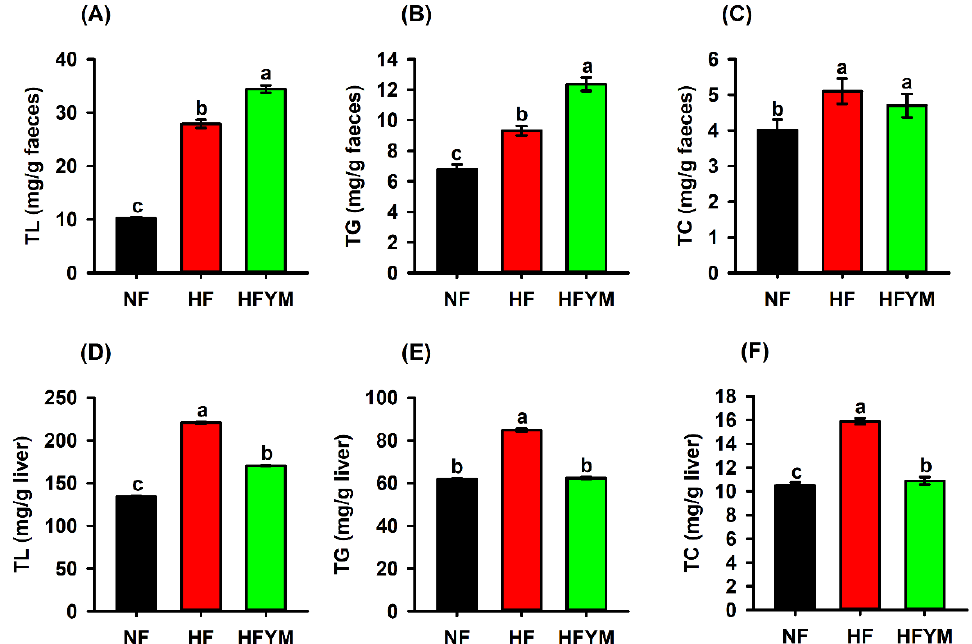
Figure 6. Total lipids (TL) ( A , D ), triglycerides (TG) ( B , E ), and total cholesterol (TC) ( C , F ) quantified in the faeces and liver of rats fed a normal-fat or high-fat diet and supplemented or not with yellow mombin. TL = total lipids; TG = triglycerides; TC = total cholesterol; NF = normal-fat diet; HF = high-fat diet group; HFYM = high-fat diet group supplemented with yellow mombin. Data are repre- sented with mean ± standard deviation. (a, b, c) Different lowercase letters in the bars indicate that there was a statistical difference among the groups (one w ay ANOVA followed by Tukey’s post - test, p ≤ 0.05).